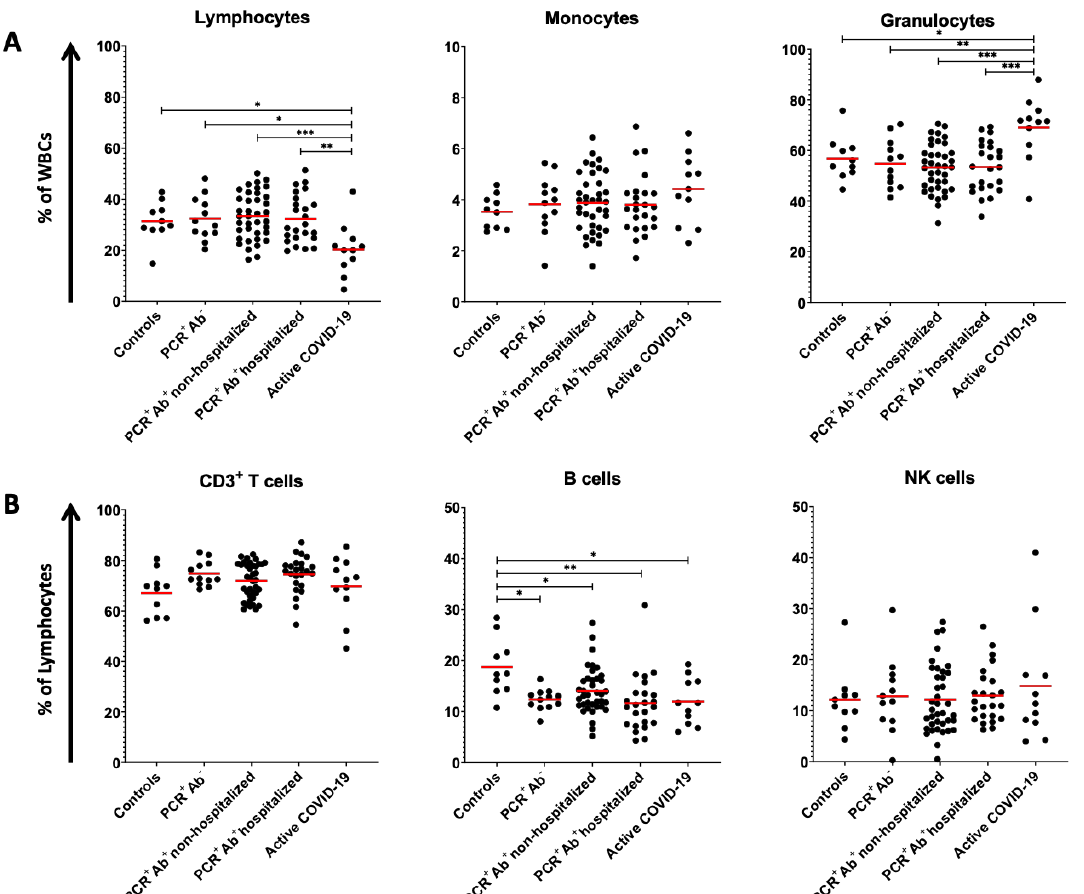
Figure 1. Distribution of ( A ) lymphocytes, monocytes, and granulocytes as percentage of white blood cells (WBCs) and ( B ) CD3 + T, B, and NK cells as percentage of lymphocytes in healthy donors (controls), the three groups of recovered CP donors and active COVID-19 patients. Each point represents the percentage determined for each single donor or patient. Bars show mean values. *, p < 0.05; **, p < 0.01; ***, p < 0.001(one-way ANOVA; post-hoc analysis by Holm–Sidak test).